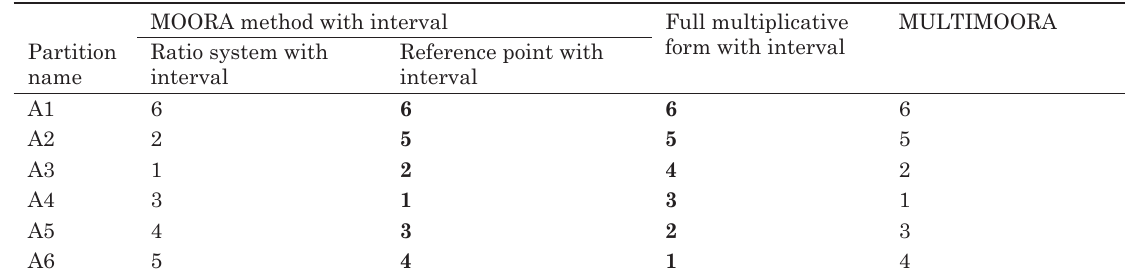
Table 5. Ranking efficient interval MOORA method with interval Full multiplicative